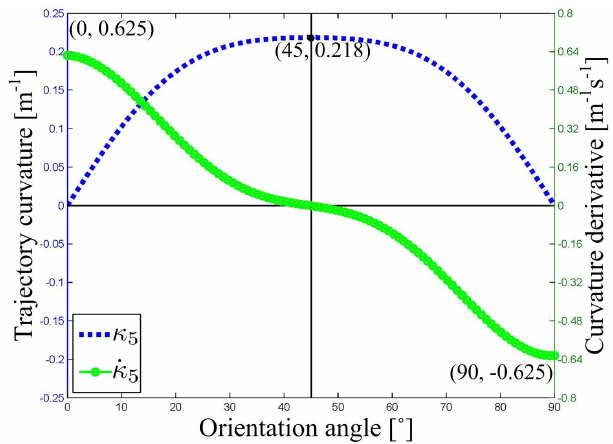
Figure 10. The curvature of the Lamé curve and its